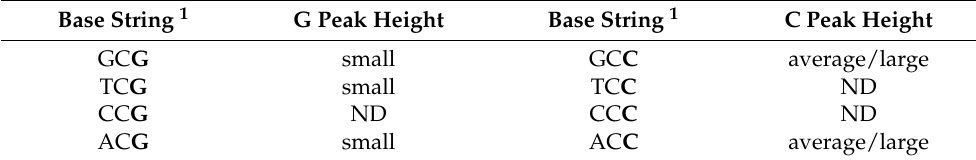
Table 2. Peak patterns in Taq-FS sequencing traces with 5 (cid:48) -NCS-3 (cid:48) base strings following